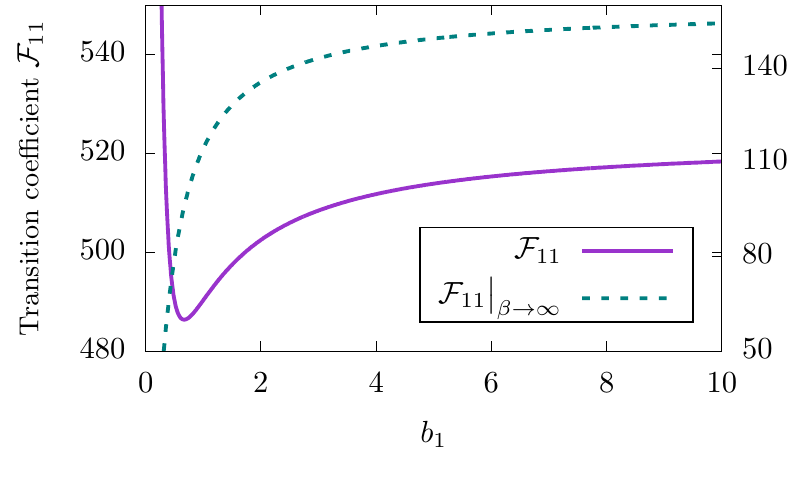
β γ is plotted with respect to varying b 1 , depicted by dash-dotted blue 1 se β γ is plotted with respect to varying b 1 , depicted by red line. 1 ae